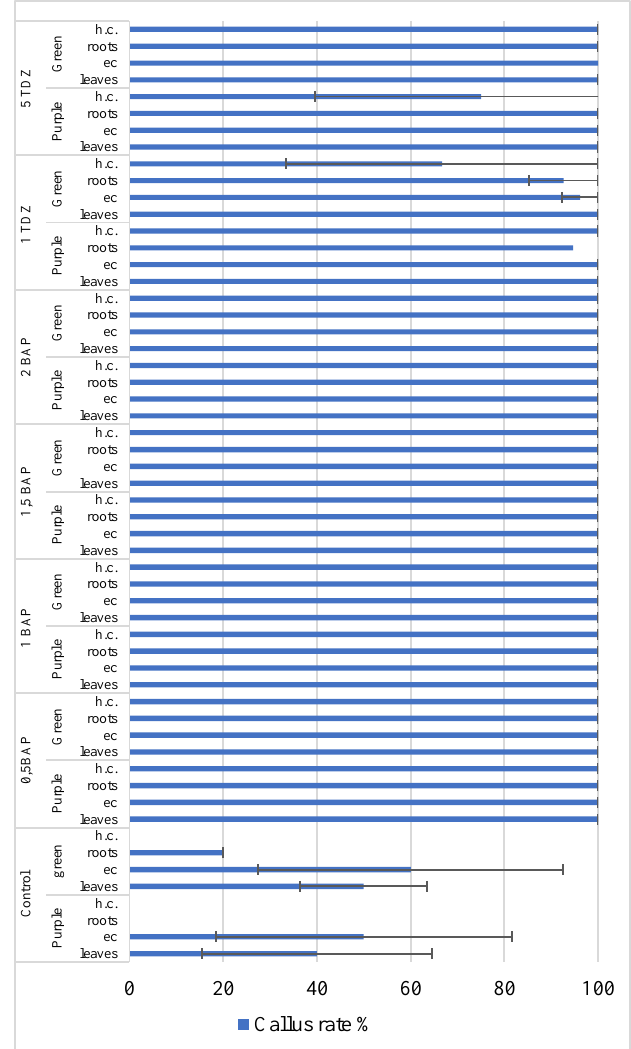
Figure 4. Rooting percentage of different explants of different O. basilicum varieties h.c: hypocotyl, e.c: epycotyl